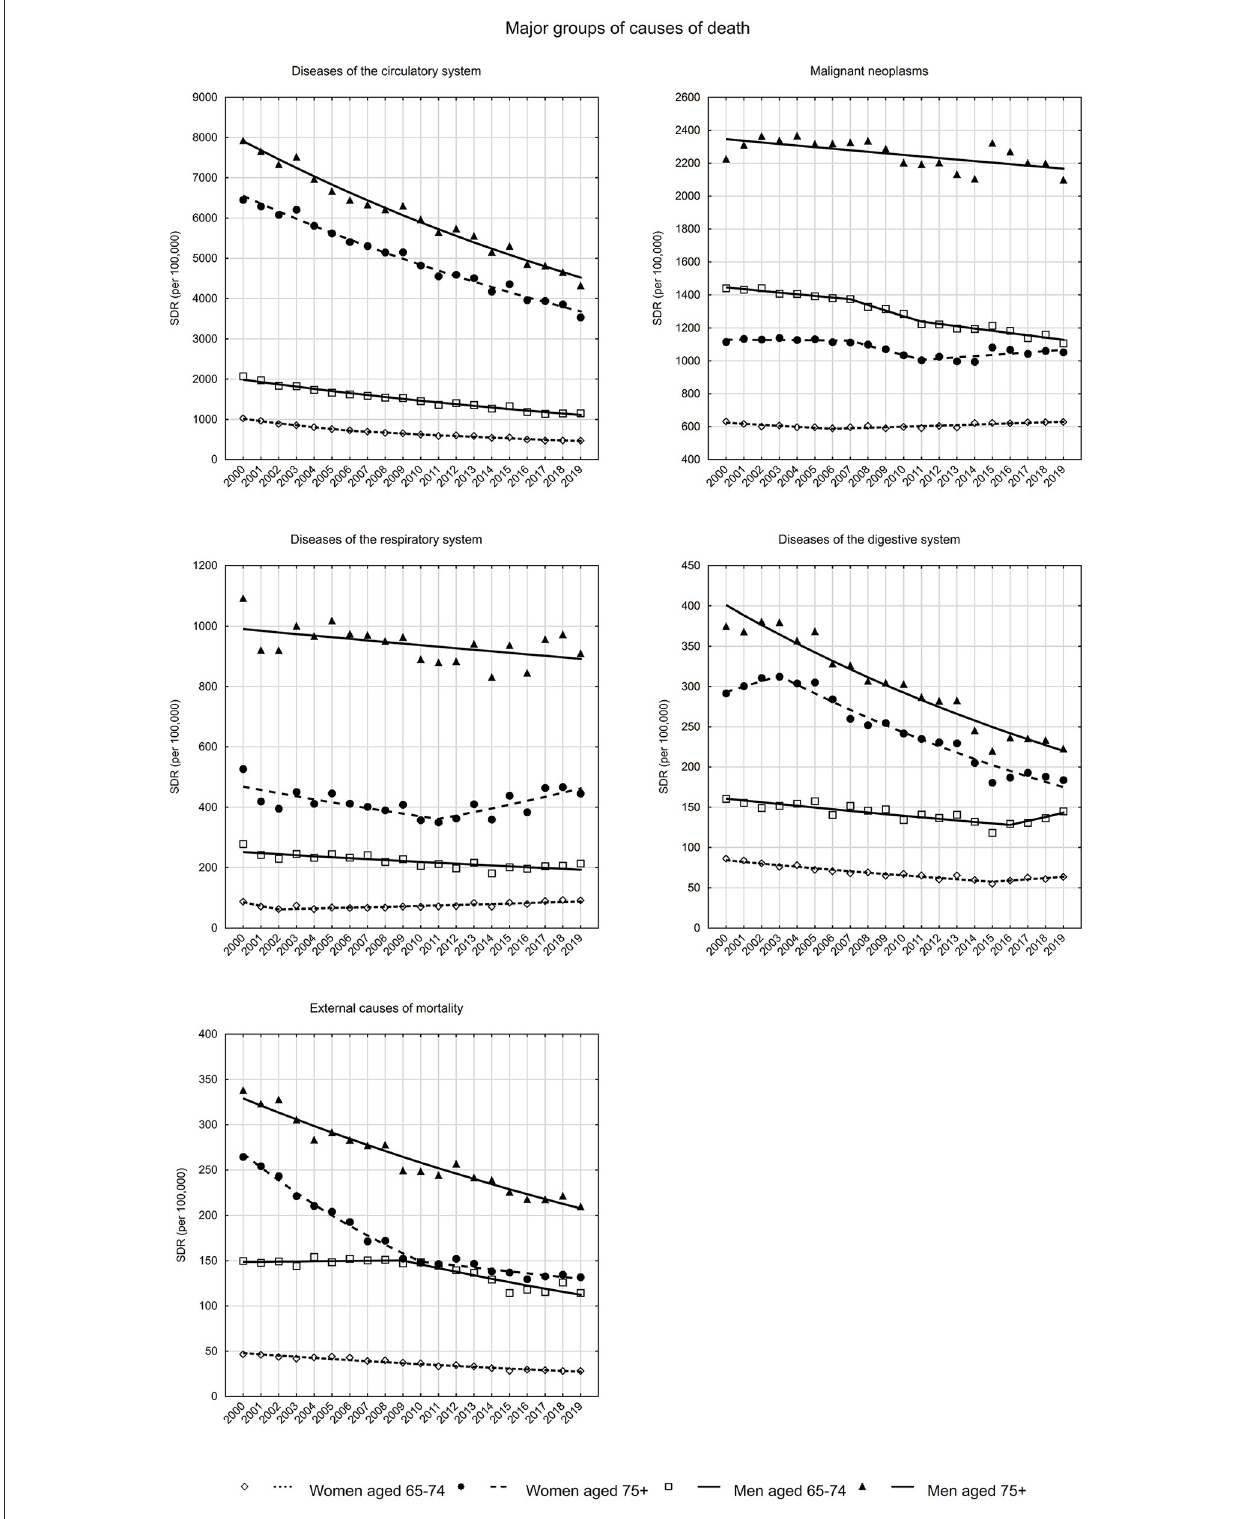
FIGURE1 SDR trends in the Polish population aged 65–74 years and 75 years and older due to major groups of causes of death in the years 2000–2019.